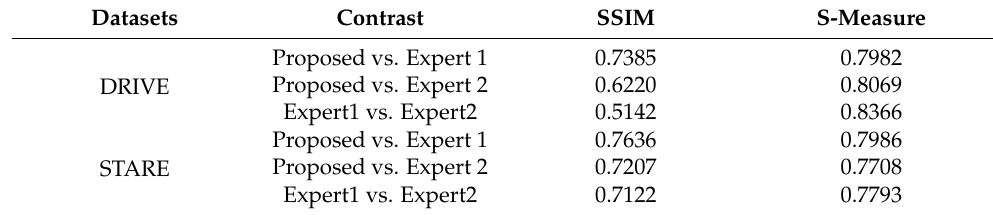
Table 4. Performance Metrics of Proposed Method.